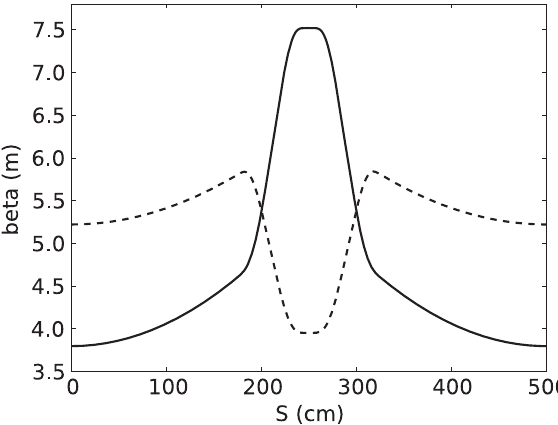
FIG. 55. Horizontal (solid) and vertical (dashed) beta functions ¼ 11 and a DF ratio of 1.17. through cell with k=x 0